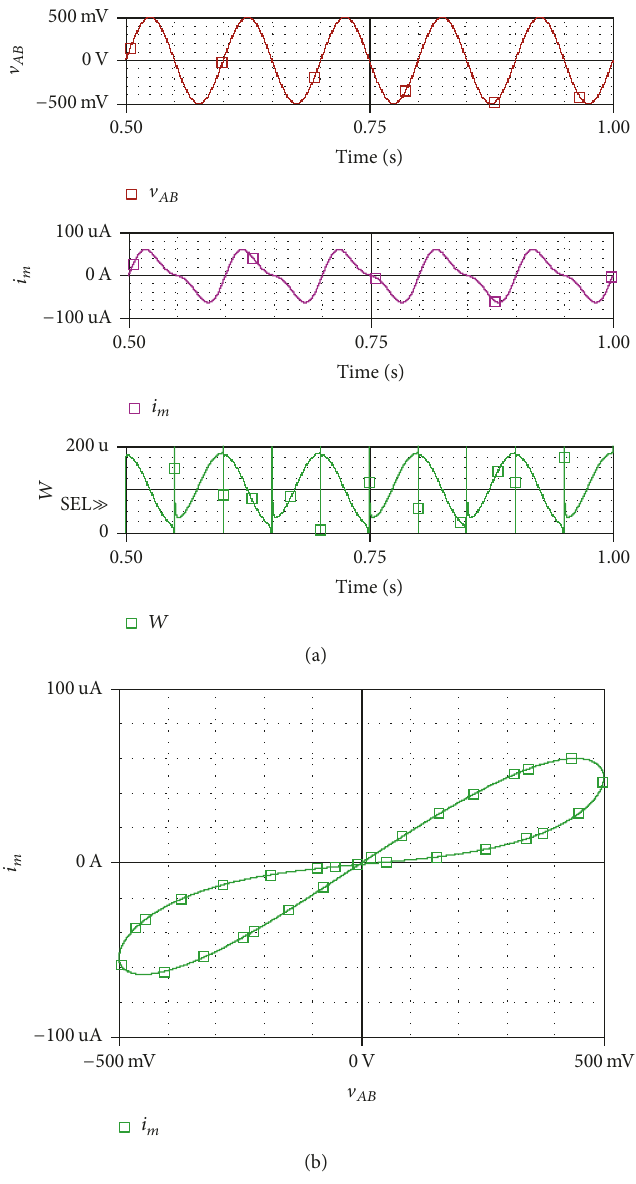
Figure 3: PSpice simulation results obtained with the decremental type memristor. (a) Time waveforms of the input voltage V 𝐴𝐵 , the input current 𝑖 𝑚 , and the memductance W ; (b) hysteresis loops in V - 𝑖 plane operating at